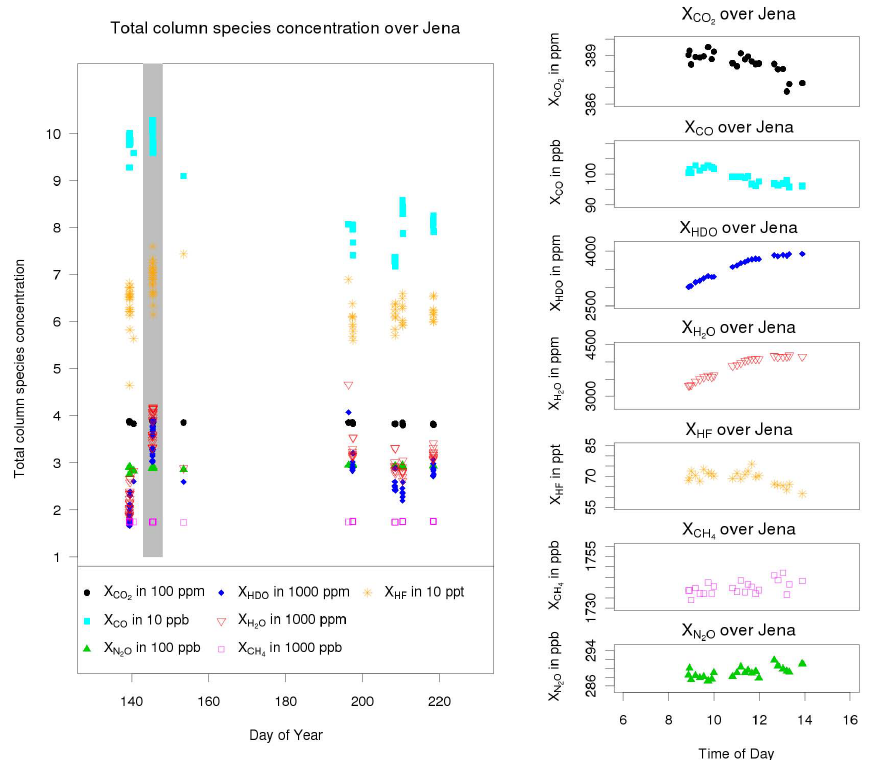
Fig. 12. Standard TCCON anaysis of measurements taken with Jena FTS 2009. The right column of plots show the diurnal variation of the species for the day marked in the left